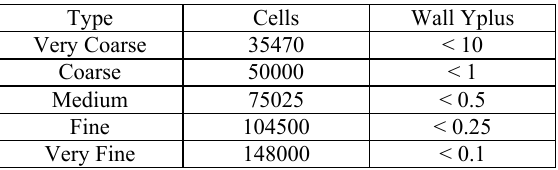
Table 2: Details of Grid density and Wall Yplus values Type Cells Wall